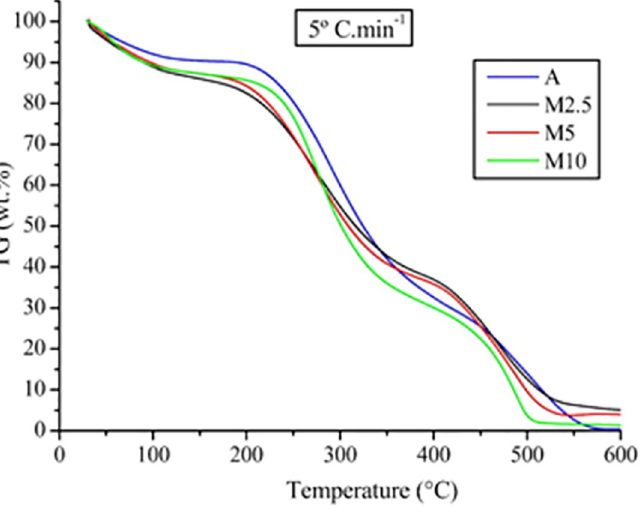
Fig 3. TGA curves at 5 º C/min of S . platensis cultivated under autotrophic and mixotrophic